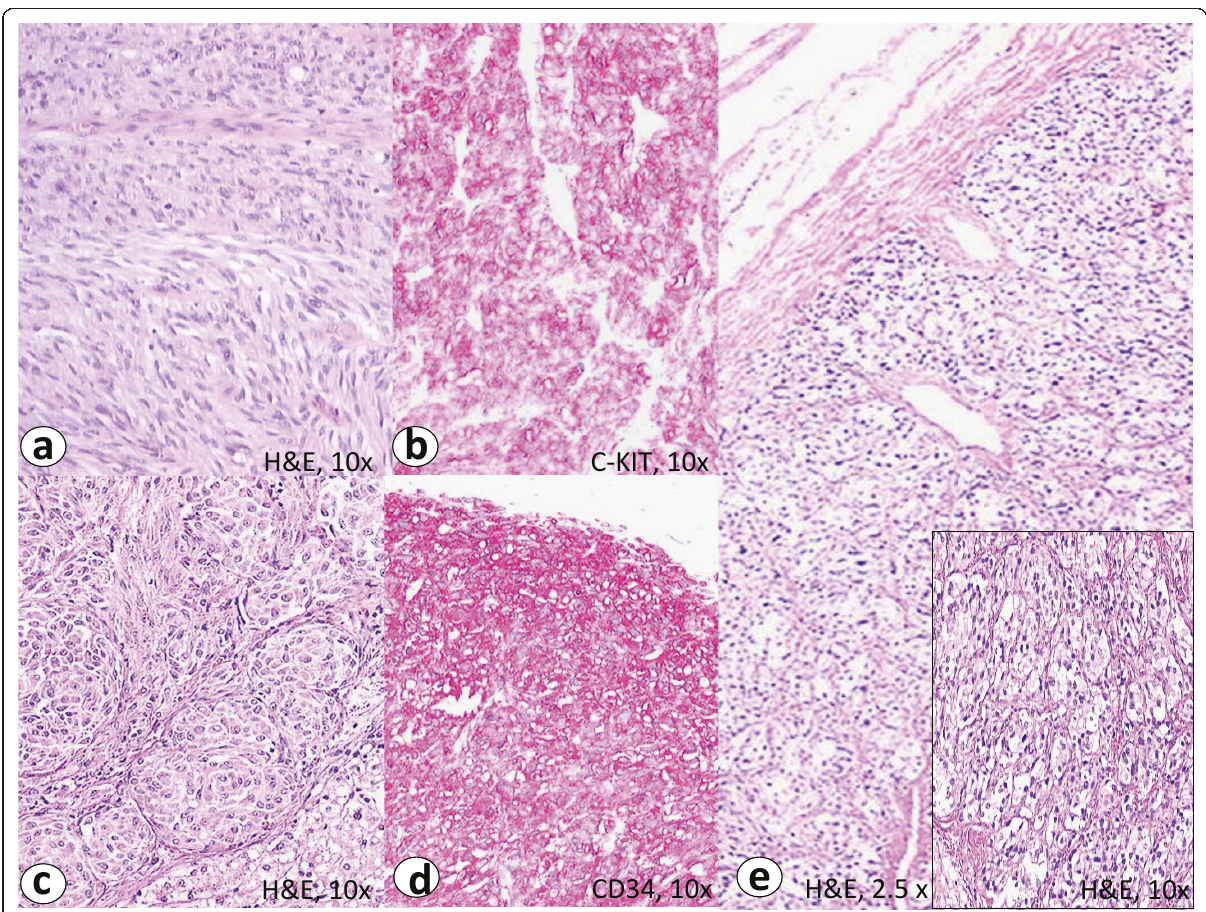
Figure 1 The primary tumor of the CT-GIST (case 1) showed a biphasic histomorphological growth pattern with spindled and epithelioid cells (a, H&E staining) . Immunohistochemistry revealed an intensive predominantly membranous staining with C-KIT (b) and CD34 (d). The liver metastases revealed small nests and “ Zellballen ” of tumor cells with epithelioid growth pattern (c, H&E staining). The paraganglioma showed a characteristic nested pattern (e, H&E staining). Note similarity to hepatic metastasis from GIST in